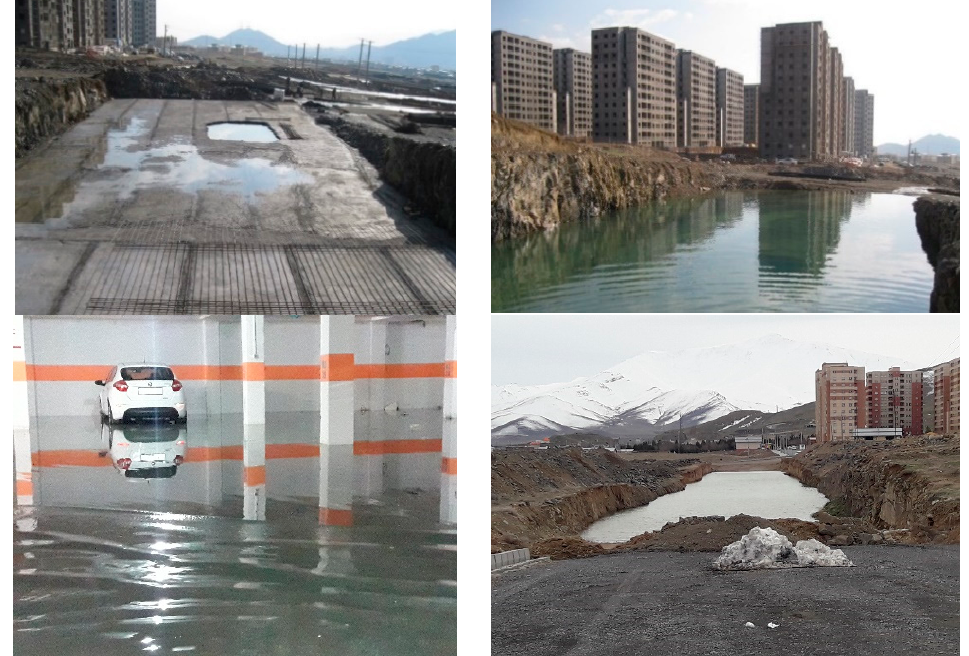
Figure 2. Water accumulation in the northern part of the study area with residential use during 2 days of rainfall in 2021, which has led to the complete burial of urban facilities, buildings and roads.